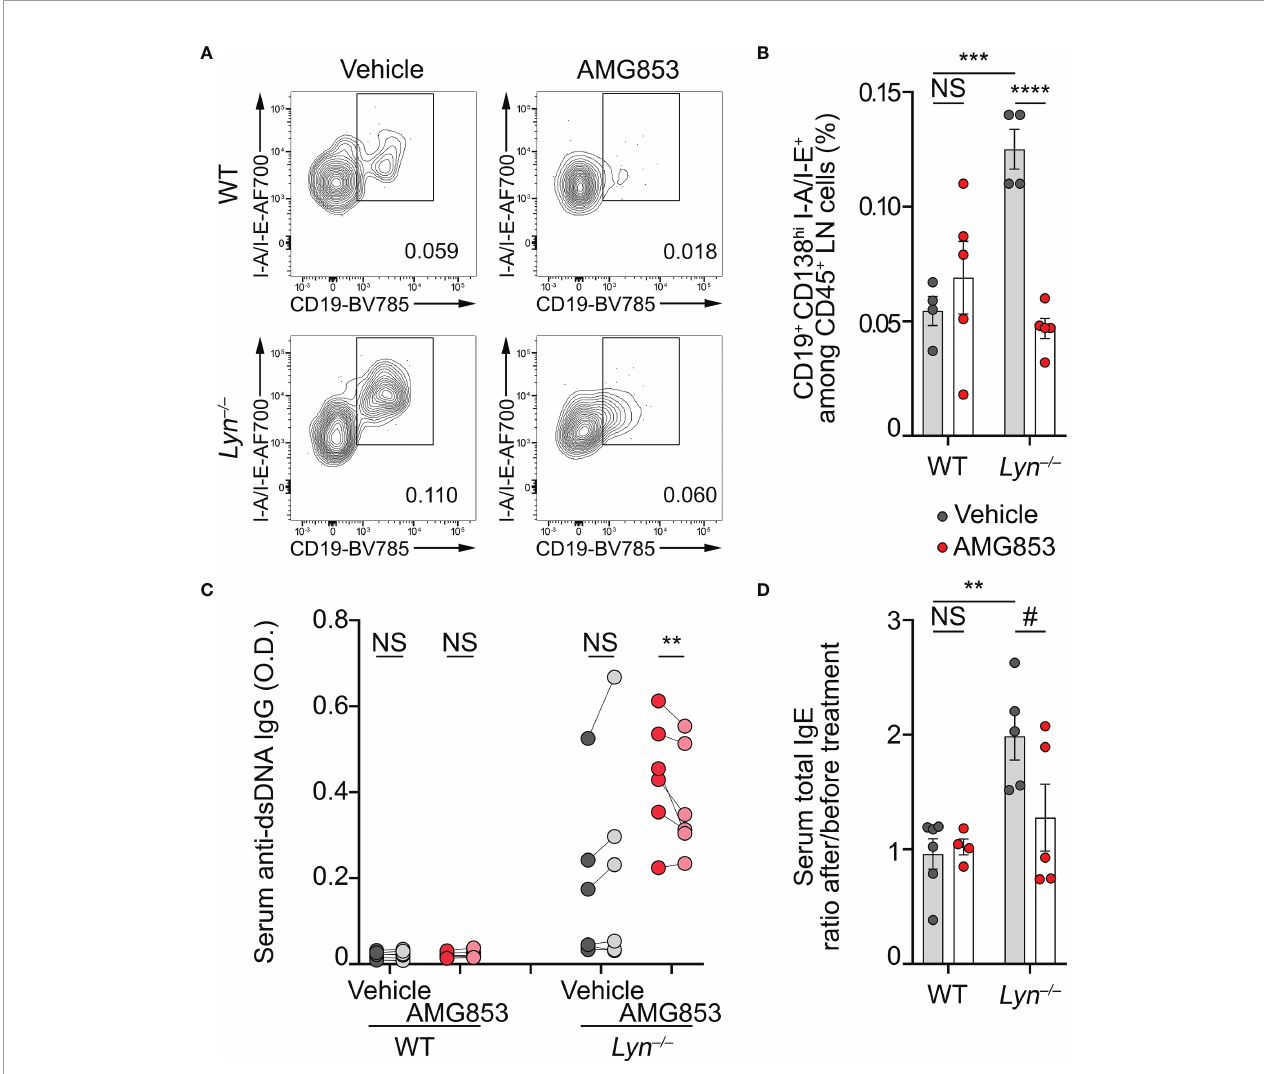
FIGURE 3 | AMG853 dampens plasmablast accumulation, autoantibody titers, and the TH2 environment in Lyn − / − mice. Aged (40 – 50 weeks) wild-type (WT) and Lyn − / − female mice were treated daily for 10 days by oral gavage with AMG853 ( n = 5 per genotype, red fi lled circles ) or vehicle (10% EtOH in tap water; n = 4 per genotype, gray fi lled circles ). (A, B) Plasmablasts quanti fi ed in peripheral lymph nodes (LNs) from the indicated animals by fl ow cytometry, as exempli fi ed in (A) (pre-gated on living CD45 + CD138 hi singlets) and summarized in (B) . Plasmablasts were de fi ned as CD45 + CD138 hi CD19 + I-A/I-E + cells among CD45 + viable singlets from LN cells. (C) Anti-dsDNA IgG autoantibody titers from serum samples harvested before ( dark gray - and dark red- fi lled circles ) and after ( light gray - and light red- fi lled circles ) treatment of each mouse with either vehicle ( gray fi lled circles ) or AMG853 ( red fi lled circles ). Individual values for each mouse before and after treatment are represented and linked. O.D. , optical density. (D) Total IgE titers were determined by ELISA in the serum from the indicated individuals. The ratio between individual values after treatment and values before treatment are represented. Results are from two (B) or three (C, D) independent experiments. (B, D) Individual values are shown inside bars representing the mean ± SEM. (B, D) Statistical analyses by unpaired Student ’ s t -tests between the indicated groups. (C) Statistical analyses done using two-way analysis of variance (ANOVA) followed by Holm – S ̌ ı ́ da ́ k ’ s multiple comparisons test. NS p > 0.05; # p = 0.08; ** p < 0.001; *** p < 0.001; **** p <